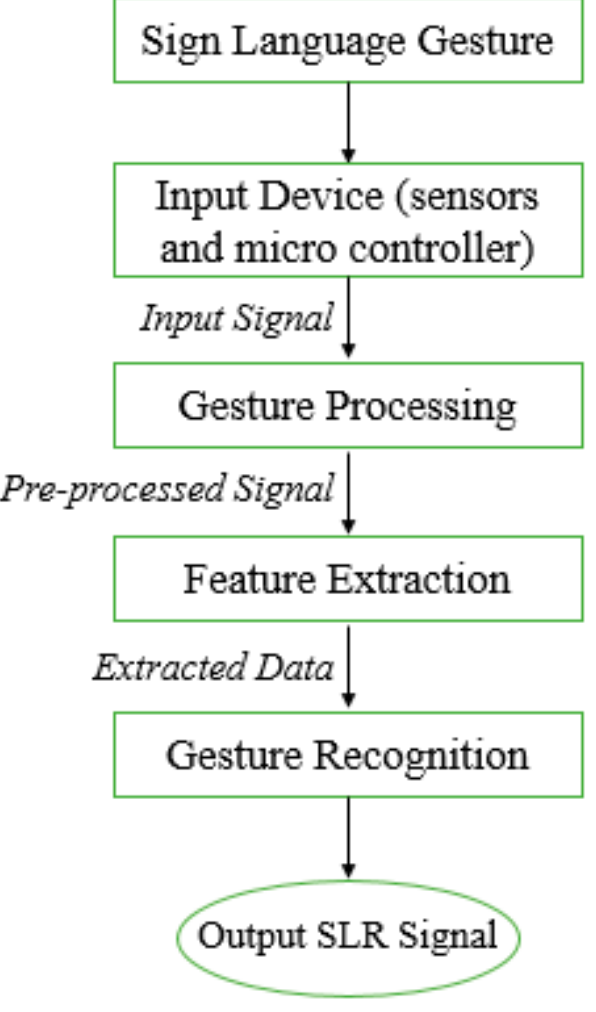
Figure 2. Processing steps for the sensor-based SLR system.